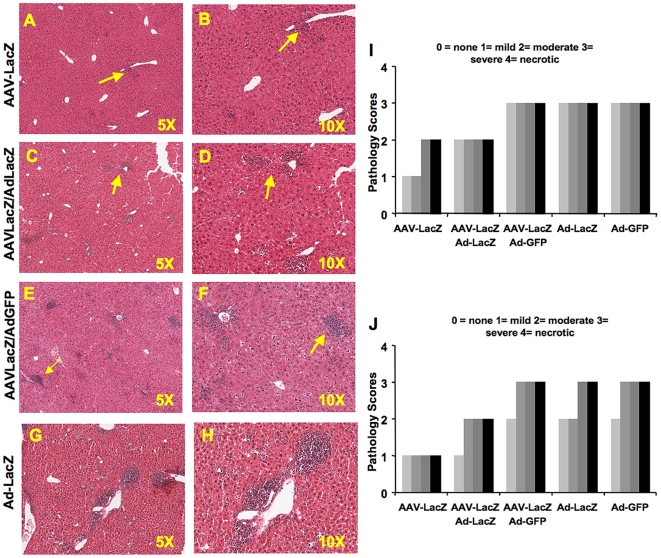
Liver inflammation.Liver sections were stained with H&E to determine levels of inflammation in the parenchyma and portal ducts at 10 days after and Ad-LacZ or Ad-GFP gene delivery to naïve mice or mice that had received AAV-LacZ gene transfer 6 weeks earlier. AAV-LacZ only transduced mice are shown for comparison (n = 4 per experimental group). A-H. Representative images at original magnification of 50x and 100x illustrate degrees of inflammation from AAV-LacZ, AAV-LacZ/Ad-LacZ, AAV-LacZ/Ad-GFP and Ad-LacZ only groups. A trained pathologist scored the liver inflammation in parenchyma (I) and portal ducts (J) in a blinded fashion to accurately determine the level of inflammation in the groups. Bars represent scores for livers of individual animals.